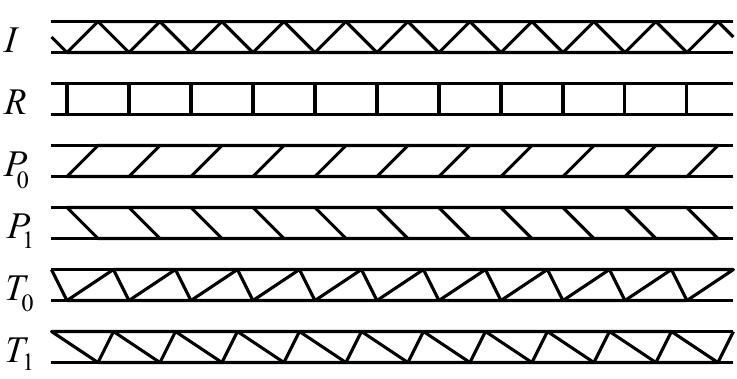
Fig. 8: Layers of isosceles triangles ( I ), layers of rectangles ( R ), layers of parallelograms ( P i ) and layers of non-isosceles triangles ( T i